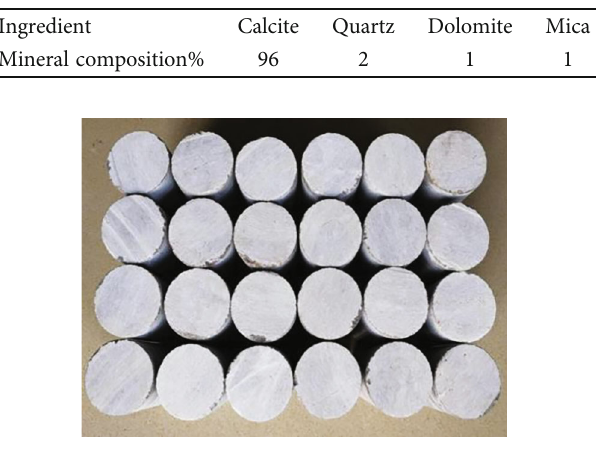
Figure 1: Limestone